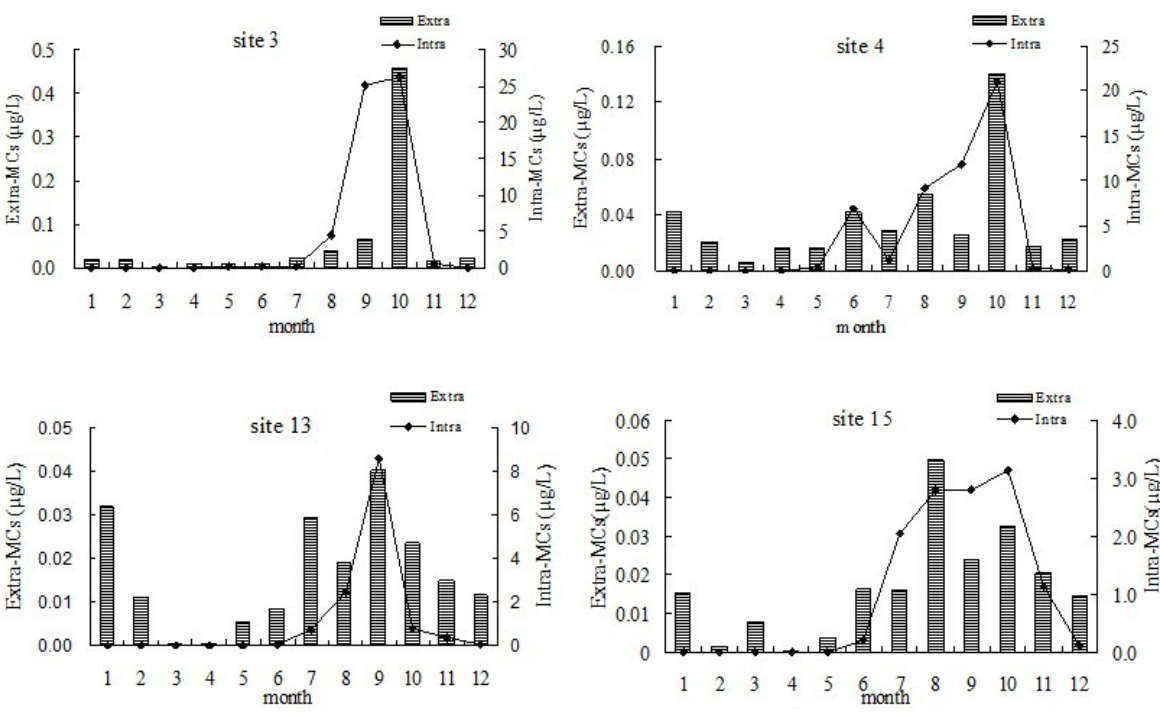
FIGURE 4. Seasonal variations of MCs (MC-RR+-LR+-YR) at Sites 3, 4, 13, and 15 in Gonghu Bay